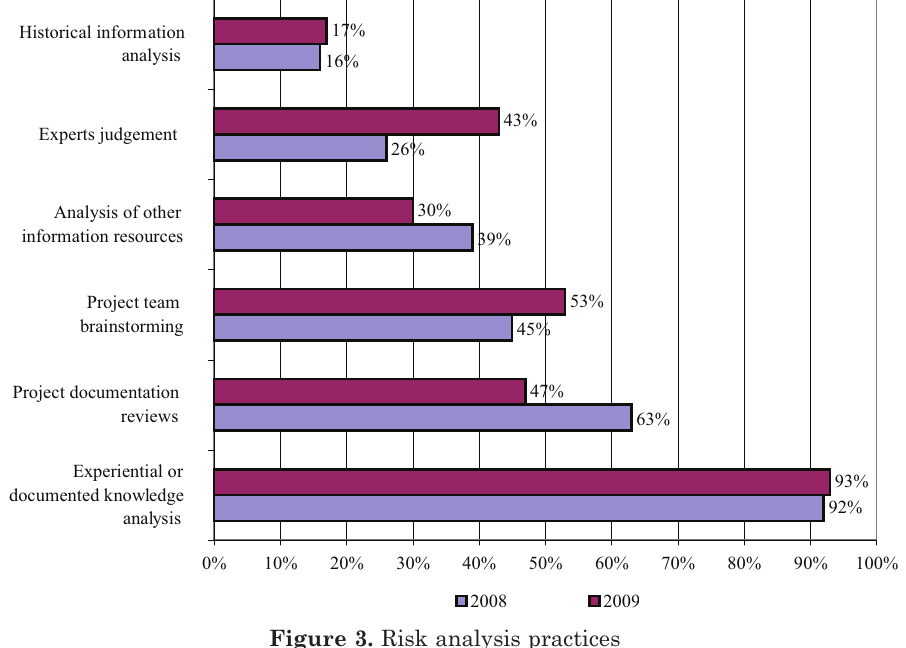
figure 3. risk analysis practices in construction